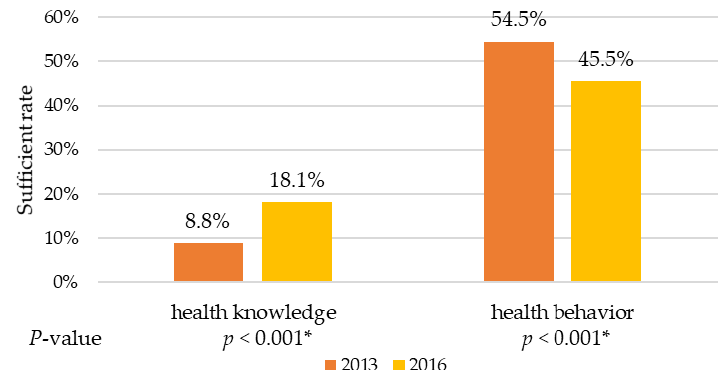
Figure 1. Overall sufficient rate of hypertension related knowledge and behavior, adjusted for age, gender, marital status, education, occupation, monthly income, and self-reported hypertension. * Statistically significant differences were detected both in knowledge (OR = 2.02, 95% CI: 1.67–2.47) and behavior (OR = 0.60, 95% CI: 0.53–0.69).